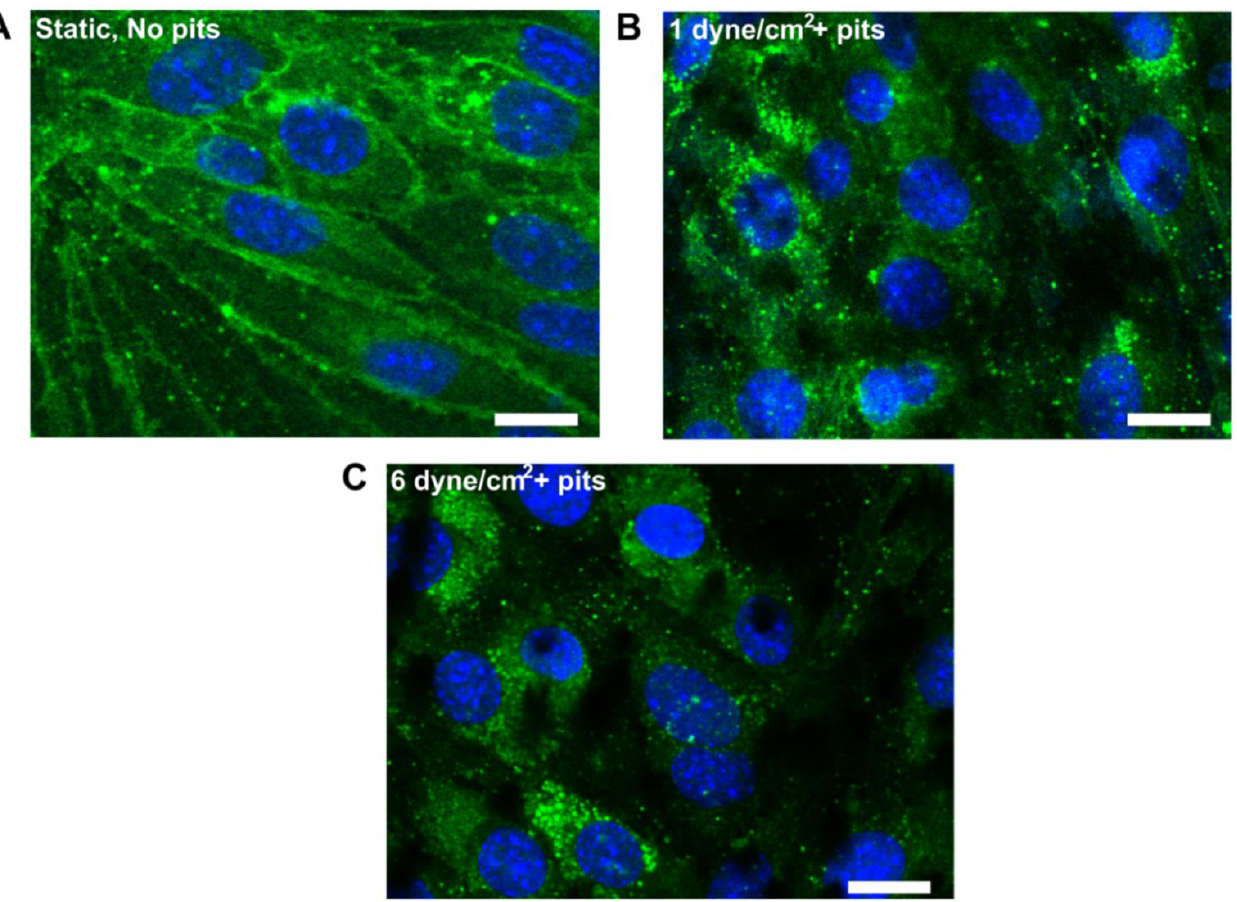
Figure 3. Characterization of microfluidic BBB model function. ( A ) Claudin-5 staining of brain EC cultured for 6 days in static cell culture plates. ( B , C ) Claudin-5 staining after 6 days static culture followed by 2 h flow. Scale bars are ~10 µm [94].